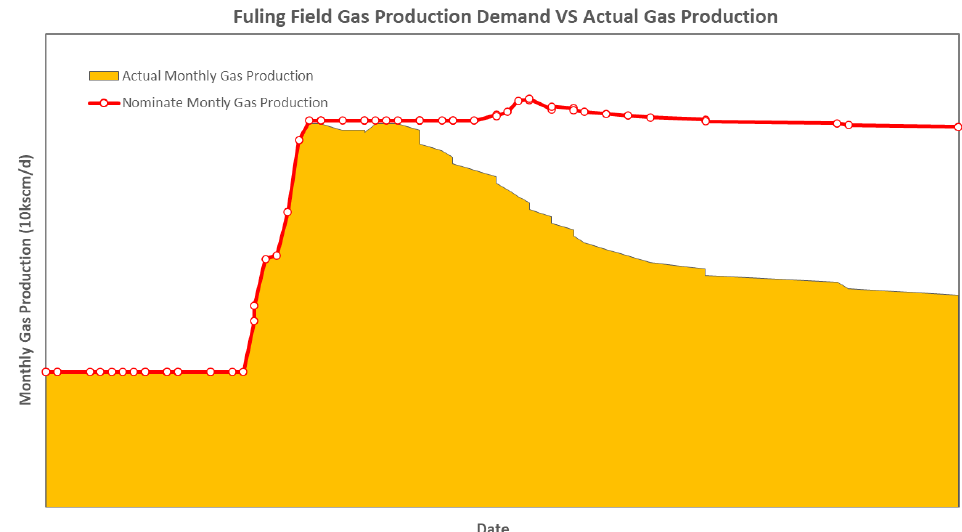
Figure 1. The main district of the Fuling shale gas field.